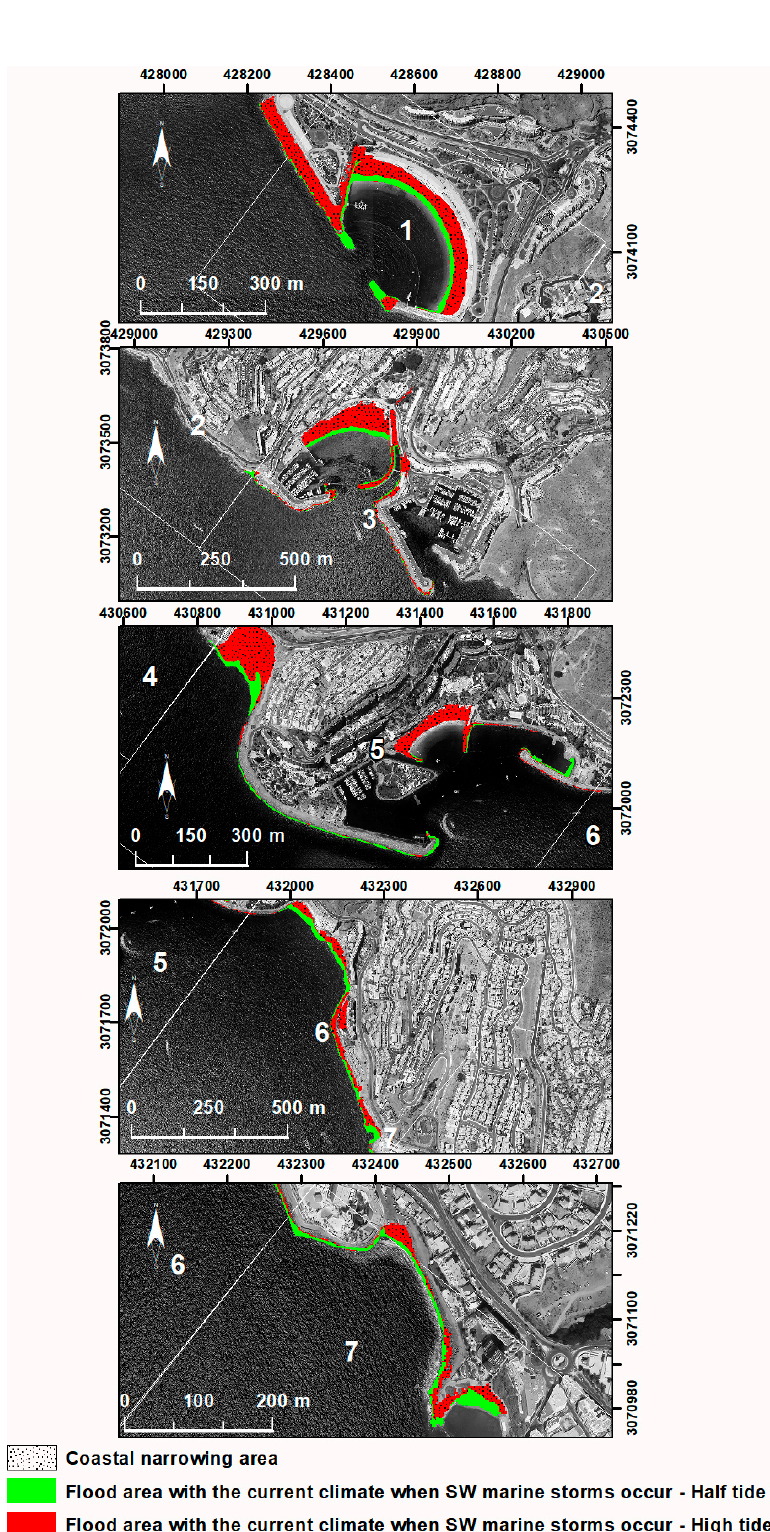
Figure 5. Study area zones affected by SW marine storms. Differences between half-tide and high tide.